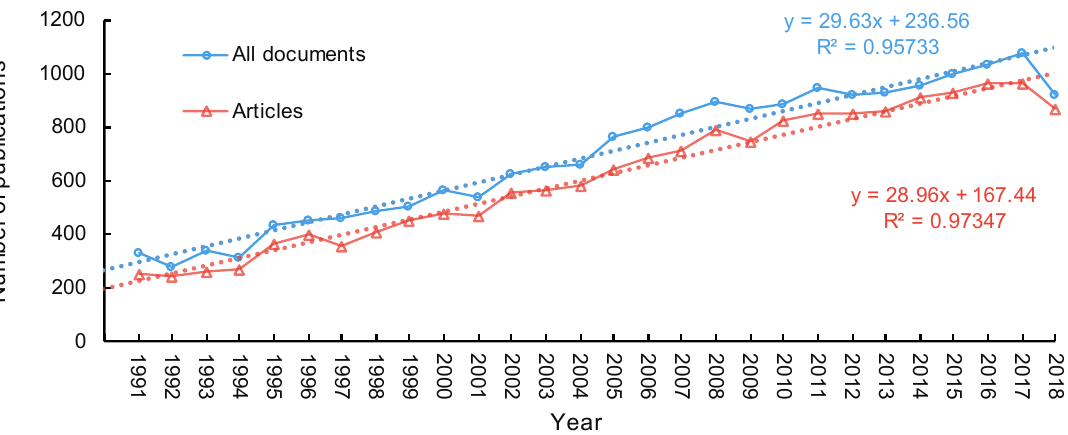
Figure 2. Journal publications with diatom in title, abstract and keywords during 1991–2018 in Web of